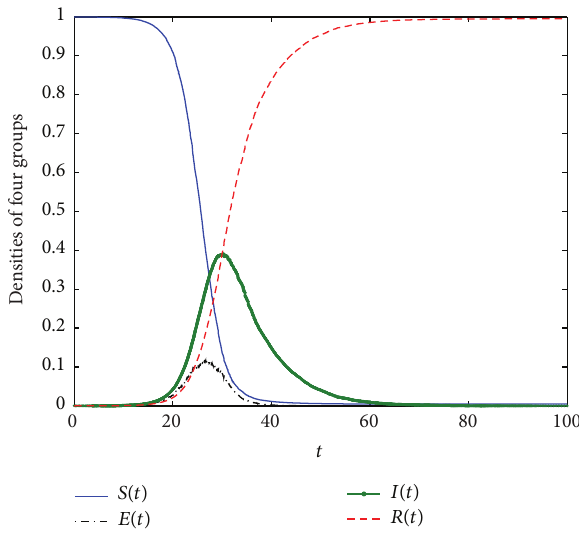
Figure 10: Densities of unaware individuals, spreaders, lurkers, and stiflers over time with 𝑐 = 0.1 , 𝑝(1) = 0.05 , 𝑞 = 0.65 , 𝑝 2 = 0.15 , and 𝑞 = 0.17